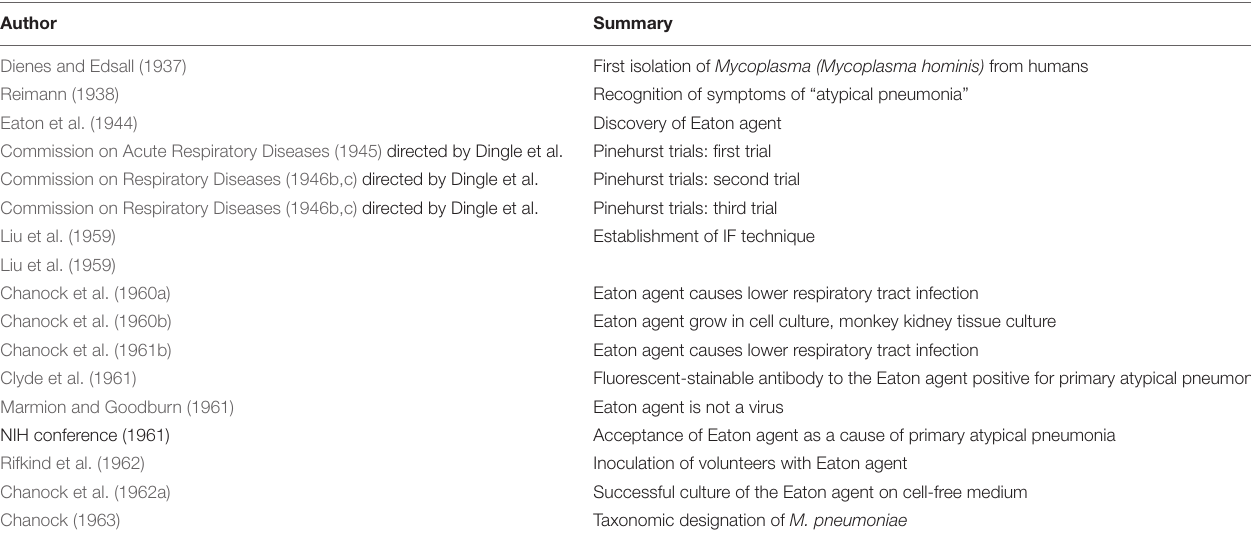
TABLE 1 | History of acceptance of the Eaton agent as a cause of primary atypical